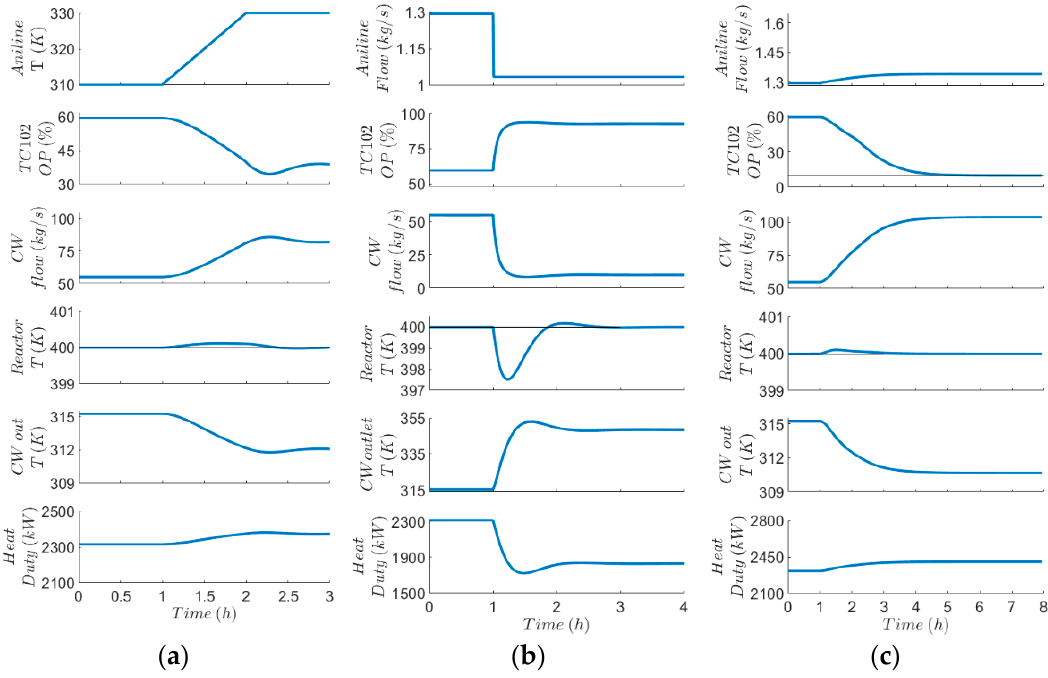
Figure 10. Control performance of plant Design C under ( a ) Scenario 1, ( b ) Scenario 2, and ( c ) Scenario 3.